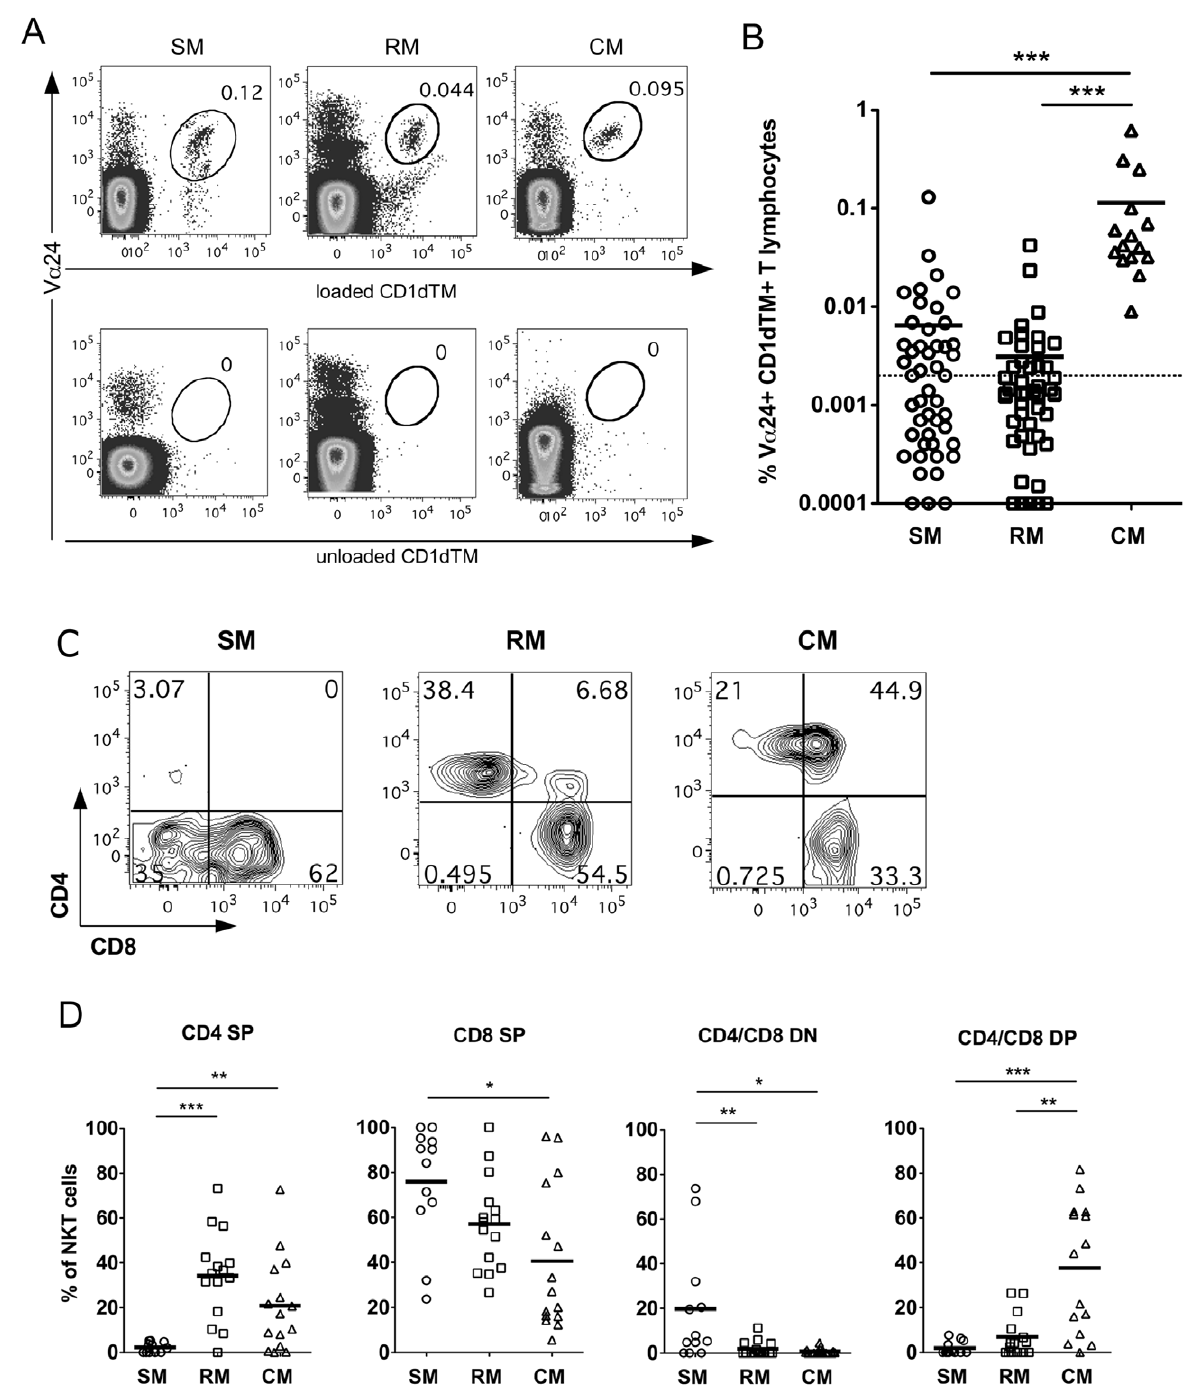
Figure 1. Comparison of NKT lymphocytes in AIDS-susceptible and AIDS-resistant nonhuman primate species. A) Dot-plots of ex vivo peripheral blood NKT lymphocytes in one SIV-negative sooty mangabey (SM), rhesus macaque (RM) and cynomolgus macaque (CM). Gated CD3 + T lymphocytes co-staining for V a 24 and CD1d tetramers loaded with PBS-57 were used to identify NKT lymphocytes (top panel). Co-staining for V a 24 and unloaded CD1d tetramers served as a negative control (bottom panel). B) Frequency of peripheral blood NKT lymphocytes in SIV-negative SM (n=50), RM (n=48) and CM (n=15). Dotted line at 0.002% denotes the cut-off for the lower limit of flow cytometric detection of NKT lymphocytes. C) Representative contour plots of CD4 and CD8 surface expression on NKT lymphocytes in SM, RM and CM. D) Frequencies of NKT subsets with CD4 + CD8 2 (CD4 SP), CD8 + CD4 2 (CD8 SP), CD4 + CD8 + (CD4/8 DP), and CD4 2 CD8 2 (CD4/8 DN) phenotype in SIV-negative SM (n=12), RM (n=15), and CM (n=15). * P , 0.05, ** P , 0.01, *** P , 0.001, Mann-Whitney U test. Horizontal bars denote mean values.